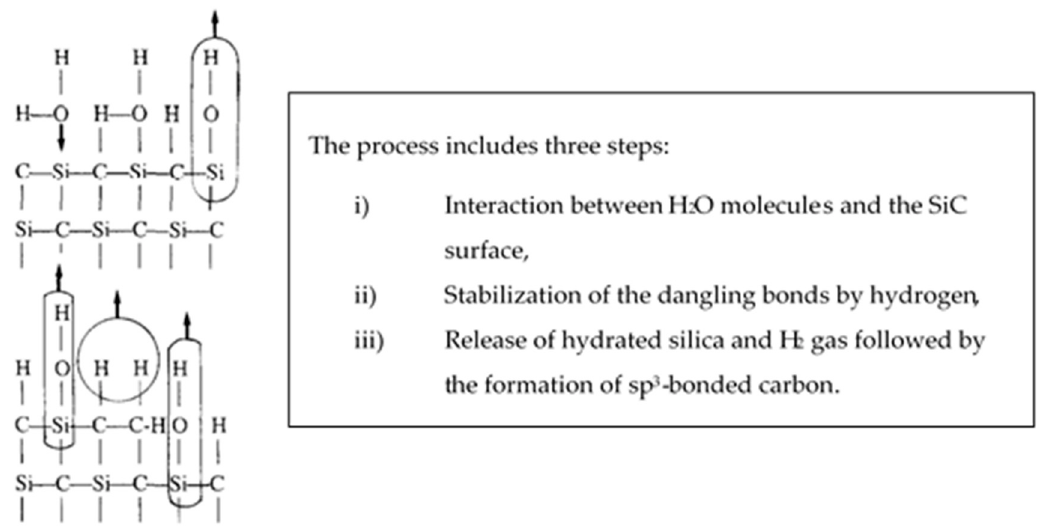
Figure 43. Two-dimensional sketch of the reaction mechanism for producing diamond. Reprinted with permission from Reference [142]. Copyright 1996 Elsevier.